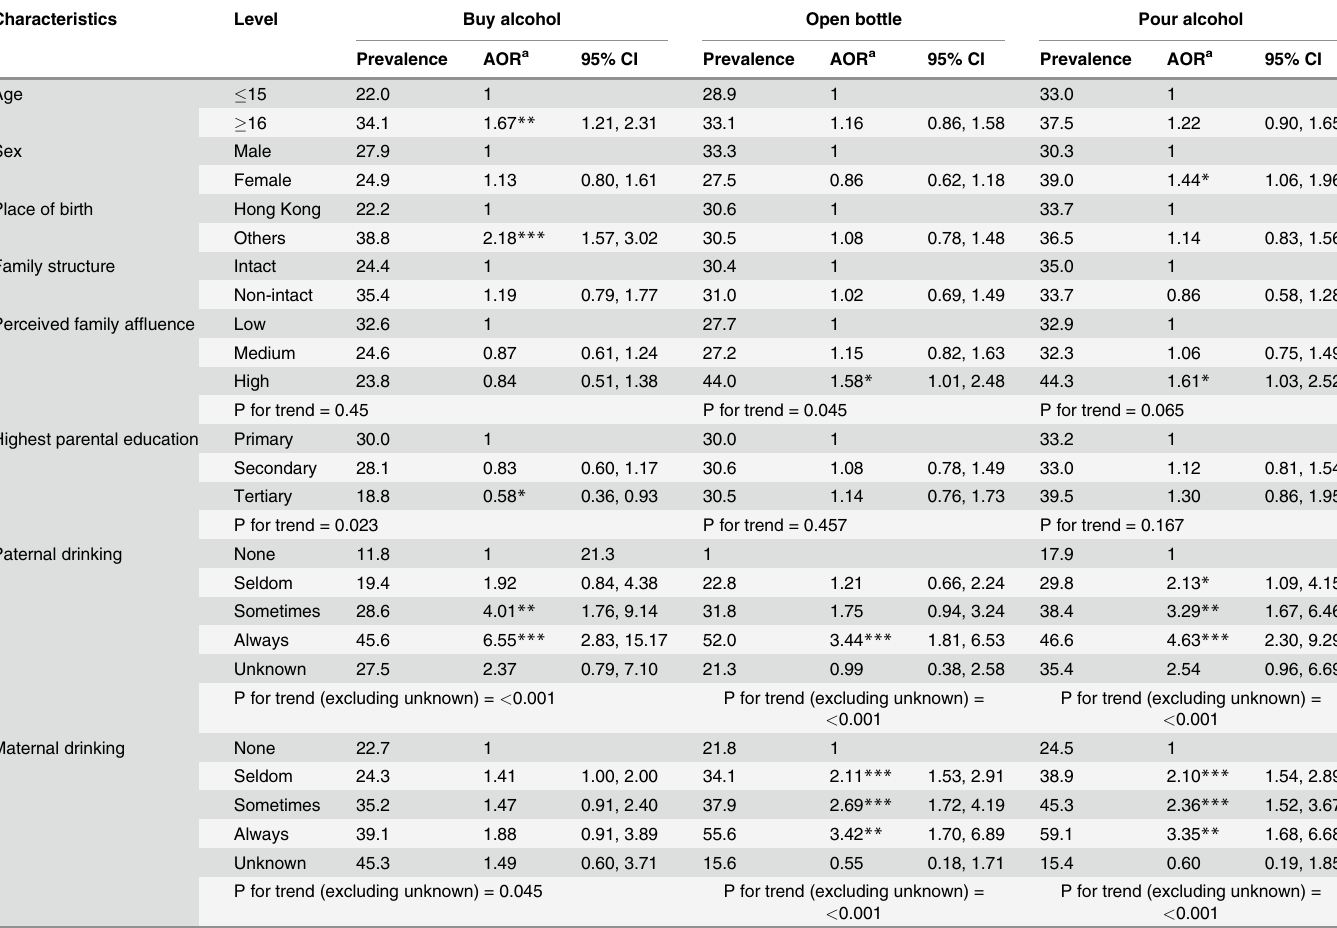
Table 4. Prevalence and adjusted odds ratios (AORs) for parents being helped to buy, open bottle and pour alcohol.